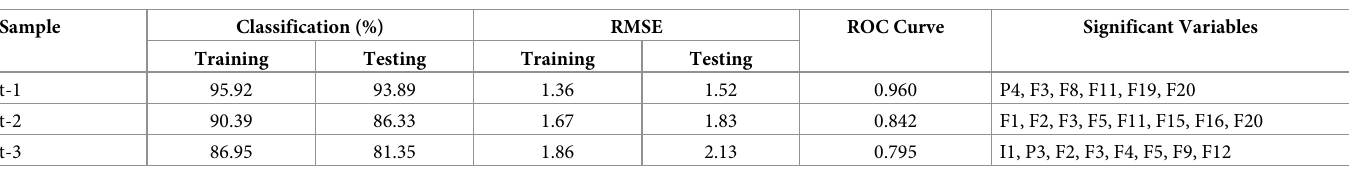
Table 3. Results of the estimated MLP